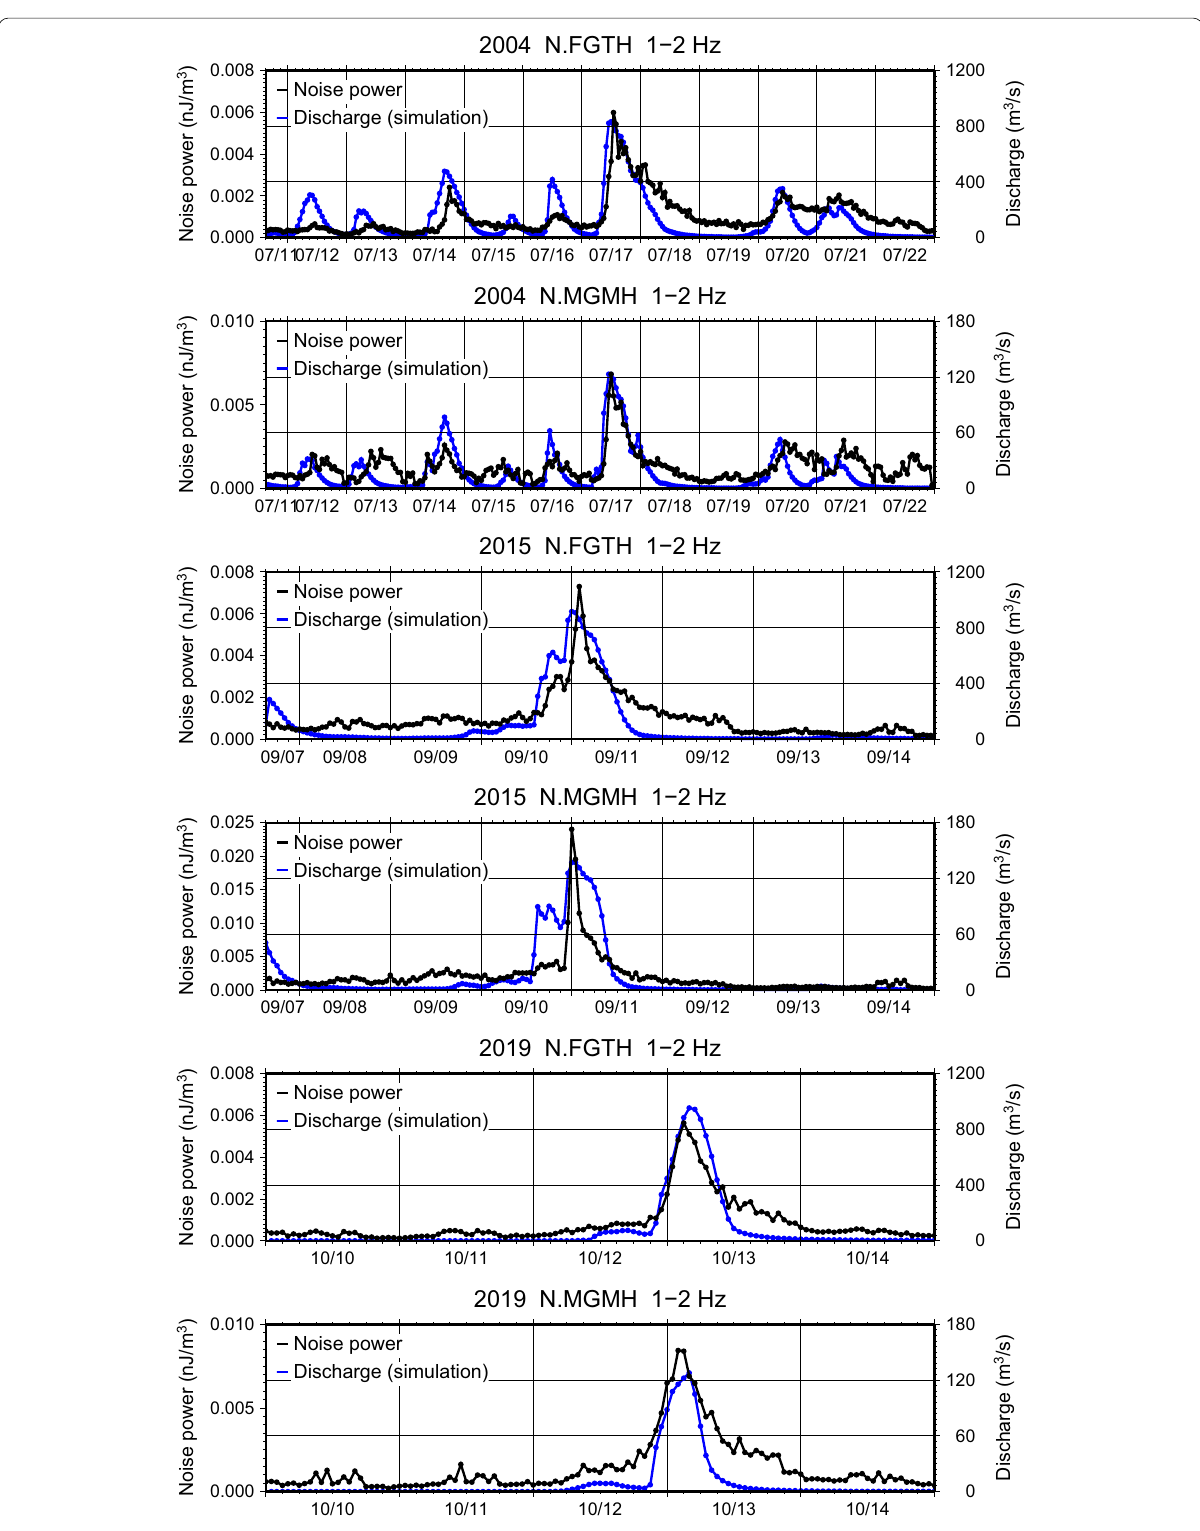
Fig. 6 Time-series profile of simulated discharge at the main river channel close to the seismic stations N.FGTH and N.MGMH and the seismic noise power of 1–2 Hz at these stations for the events of July 2004 (upper panels), September 2015 (middle panels), and October 2019 (lower